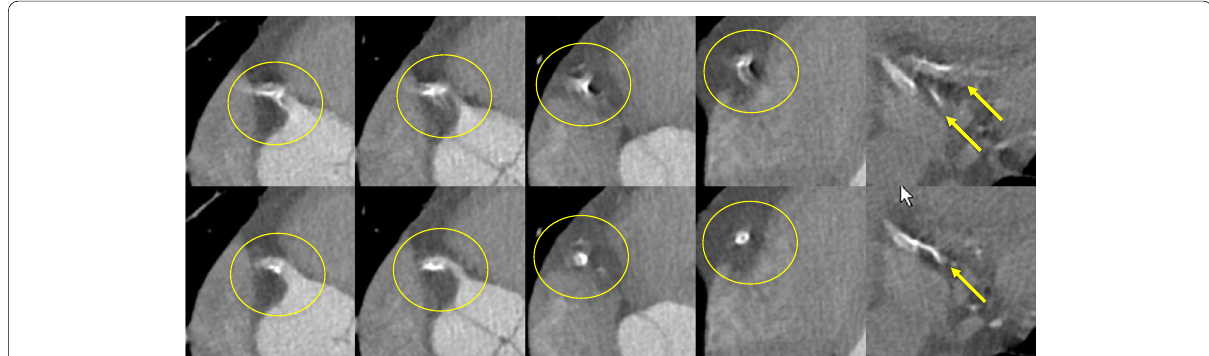
Fig. 5 Axial slices from the RCA of a patient with heart rate of 86 bpm illustrate strong motion artifacts (top). After algorithmic motion correction using SnapShot Freeze 2 (bottom) the artifacts are reduced substantially, leading to more interpretable images. The images are ordered from proximal to distal. W/L 1100/100 HU (Credit: Anzhen =